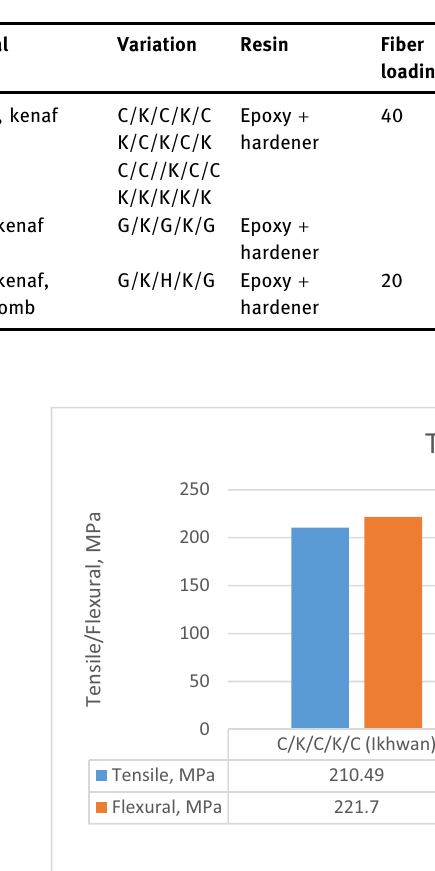
Table 1: Natural – synthetic composite detail and methodology